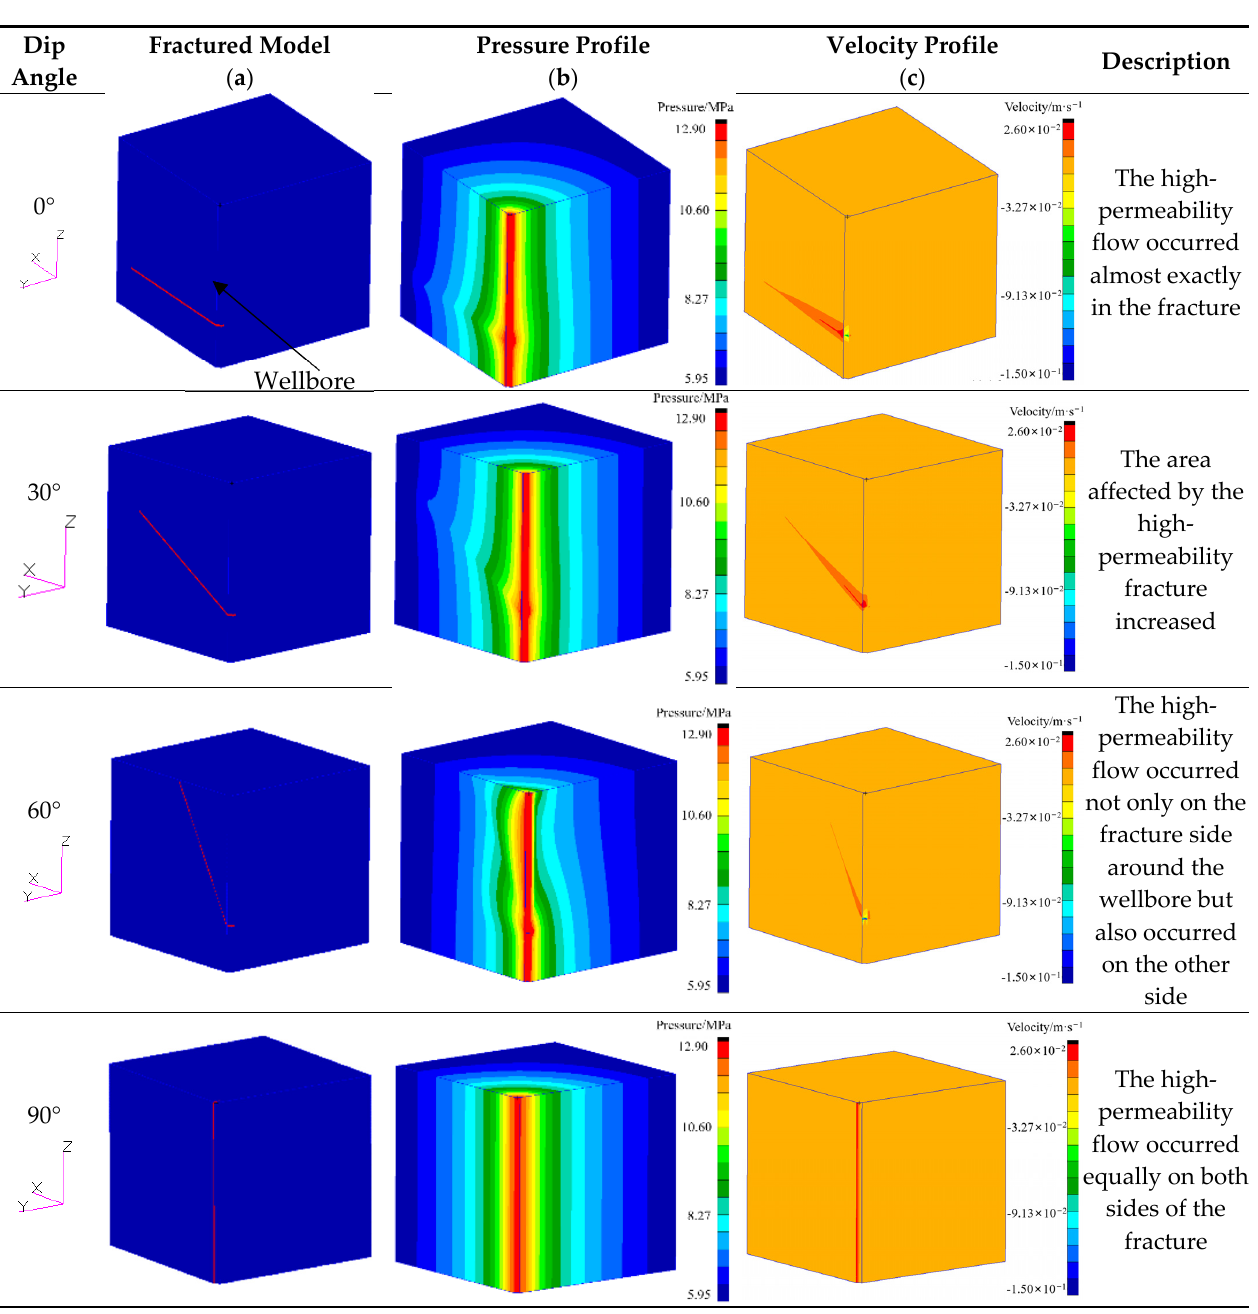
Figure 8. Fracture models with different dip angles. ( a ) Fractures (in red) in the model; ( b ) A pressure profile, MPa; ( c ) A velocity profile at the same time during water injection, m/s.